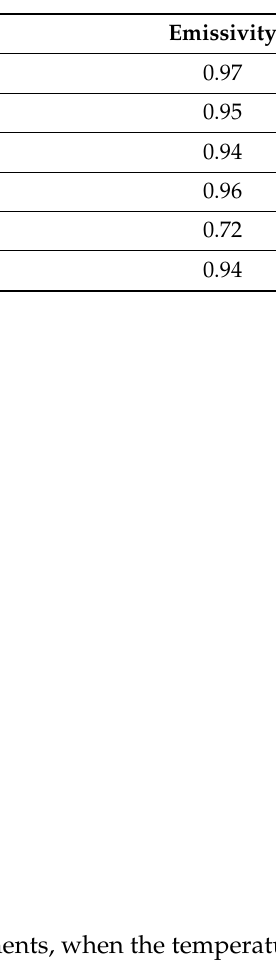
Table 1. Emissivity of various substances.